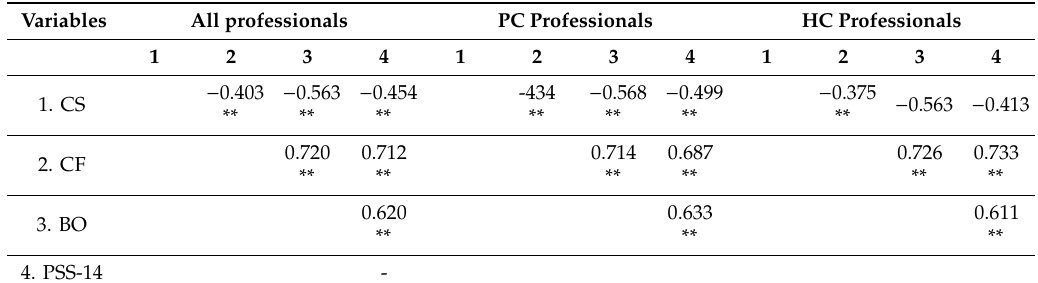
Table 4. Correlations between Quality of Life and Perceived